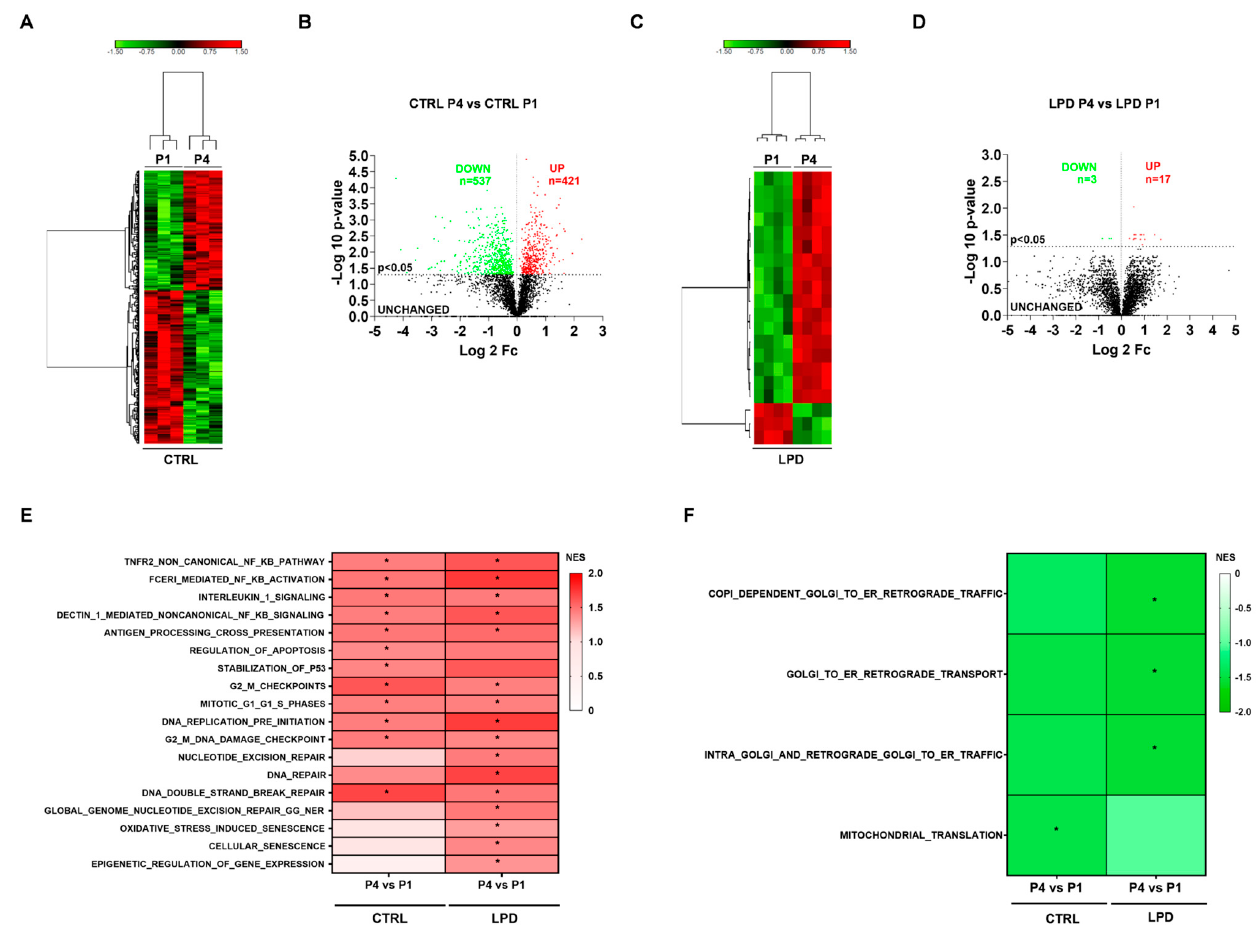
Figure 5. Early developmental changes in the microglial proteome are modified by exposure to LPD. ( A , C ) Heat maps showing the clustering in ( A ) CTRL at P1 and P4 and ( C ) LPD at P1 and P4. ( B , D ) Volcano plot showing differentially expressed proteins between ( B ) CTRL P4 and CTRL P1 and ( D ) LPD P4 and LPD P1. Upregulated proteins are depicted in red, downregulated proteins in green, and unchanged in black. ( E ) GSEA analysis performed against the Reactome pathway database. Upregulated protein sets in CTRL P4 vs. CTRL P1 and LPD P4 vs. LPD P1 are reported. ( F ) GSEA analysis performed against the Reactome pathway database. Downregulated protein sets in CTRL P4 vs. CTRL P1 and LPD P4 vs. LPD P1 are reported. * p < 0.05 vs. respective P1 time point.